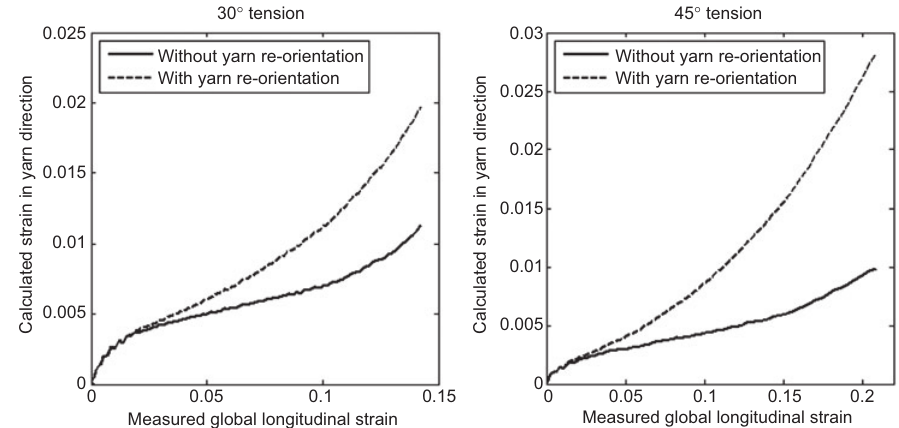
Figure 10 Calculated strain in yarn direction, with and without